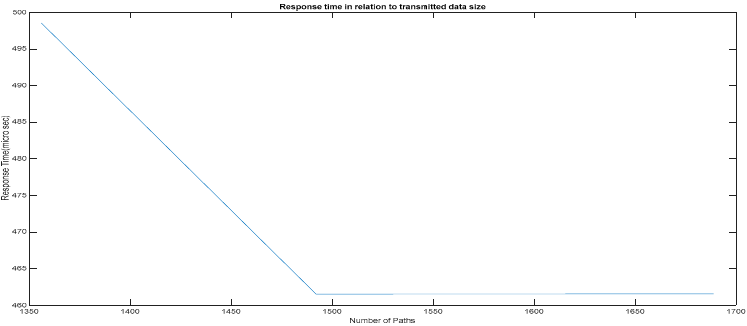
Figure 13. Response time in relation to transmitted data size.